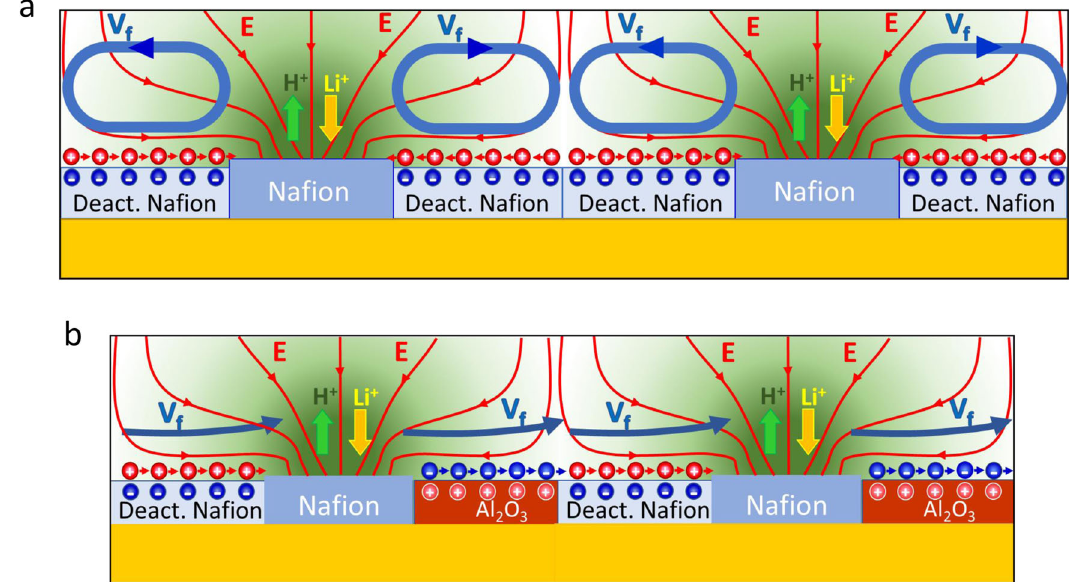
Fig. 2 From convective rolls to unidirectional pumping. a Scheme of a pump made of alternating strips of deactivated and active Na fi on, leading to the formation of multiple convection rolls along the patterned array. b Scheme of the design of a pump based on the periodic repetition of a basic unit made of alternating strips of deactivated Na fi on (negative ζ )/Na fi on/Al 2 O 3 (positive ζ ) which would lead to unidirectional fl uid fl ow along the patterned surface. The charged interface in the Na fi on has been omitted to lighten the content of the fi gure. The Al 2 O 3 patches with positive ζ accumulate negative counterions that in the presence of the tangential component of the electric fi eld generated by the ion-exchange will move also to the right, dragging the fl uid along to the next repeating unit, achieving unidirectional fl ow.